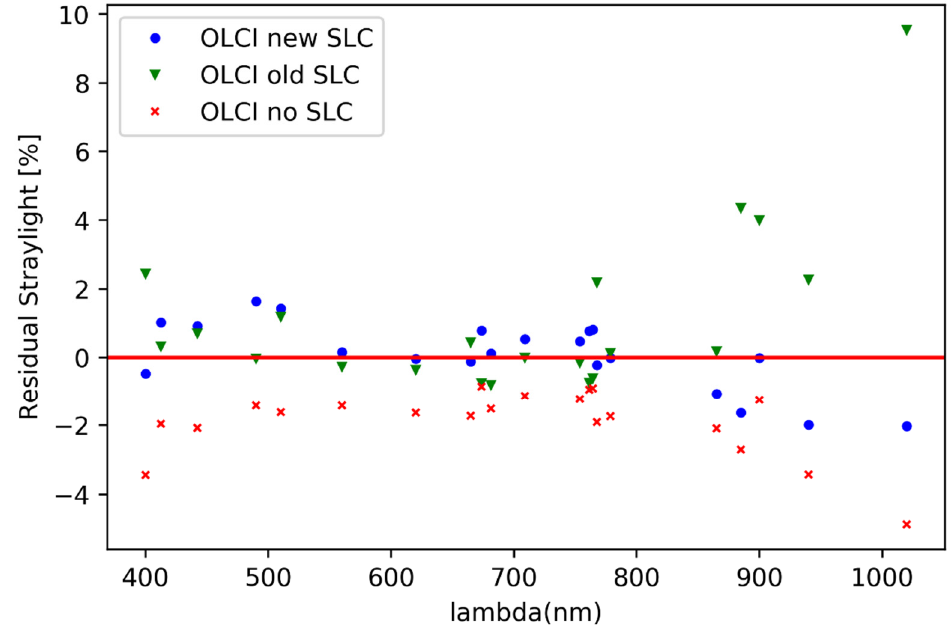
Figure 16. Residual stray-light in different SLC variants. Strong overcorrection of the longest wavelengths is replaced by slight undercorrection (negative values).